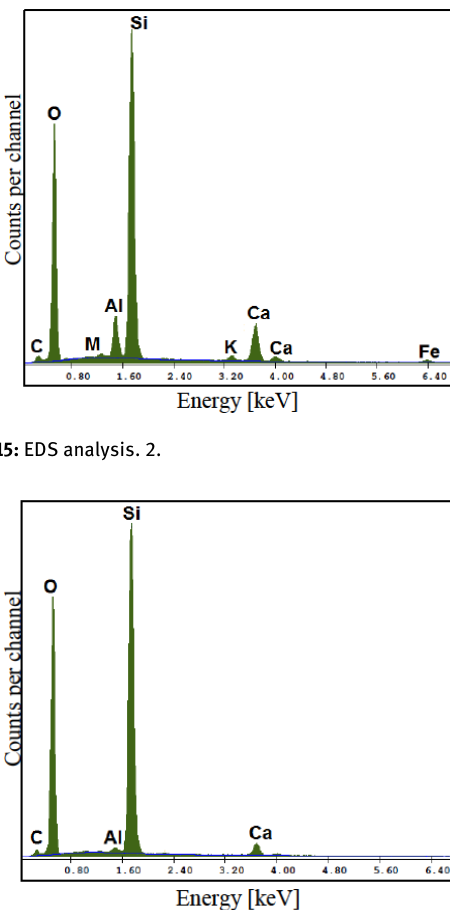
Figure 16: EDS analysis. 3.